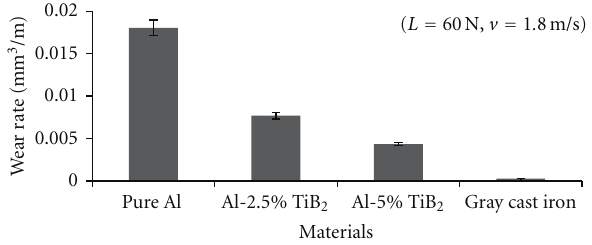
Figure 9: Wear rate variation of sliding pins made out of di ff erent materials.